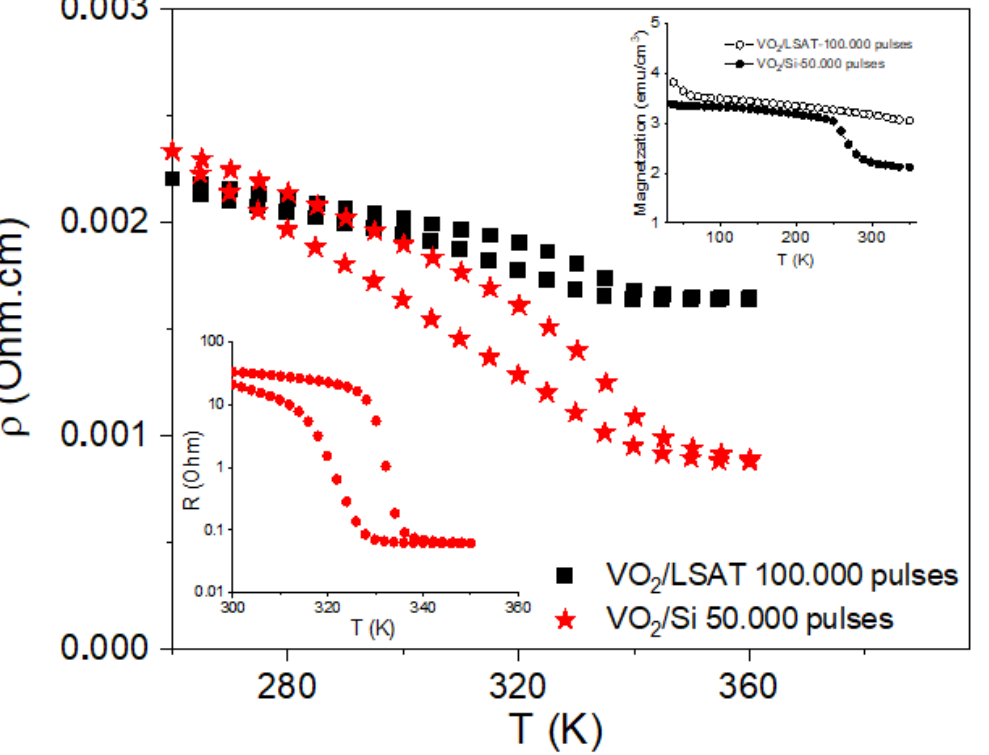
Figure 7. Temperature-dependent resistivity of S1 and S3 VO 2 films on LSAT and Si substrate, respectively. The upper inset shows the temperature-dependent magnetizations of the same films under a 300 Oe applied magnetic field, whereas the lower inset illustrates the temperature-dependent resistance of a similar VO 2 film, deposited on silica at 600 °C.